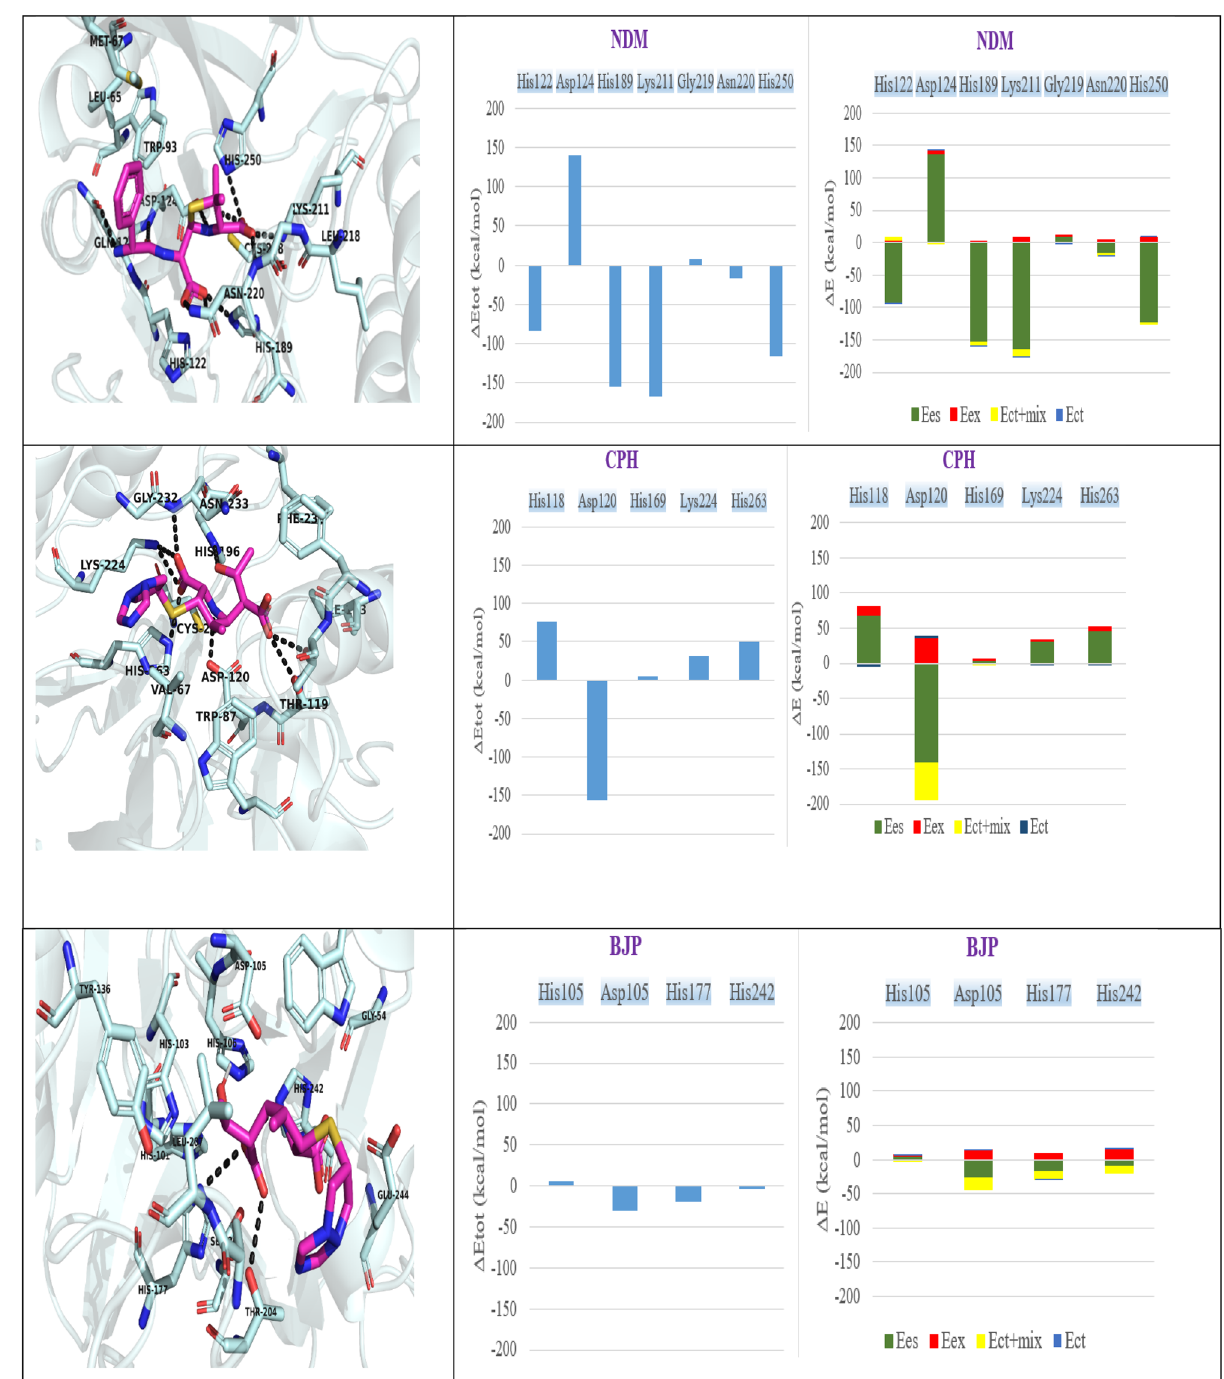
Figure 9. The right hand bar plot describes the PIEs and PIEDA of the significant residues in the binding pocket of MBLs. The electrostatic, exchange repulsion, charge transfer, Ect + mix and E total terms are coloured in green, red, dark blue, yellow, light blue,